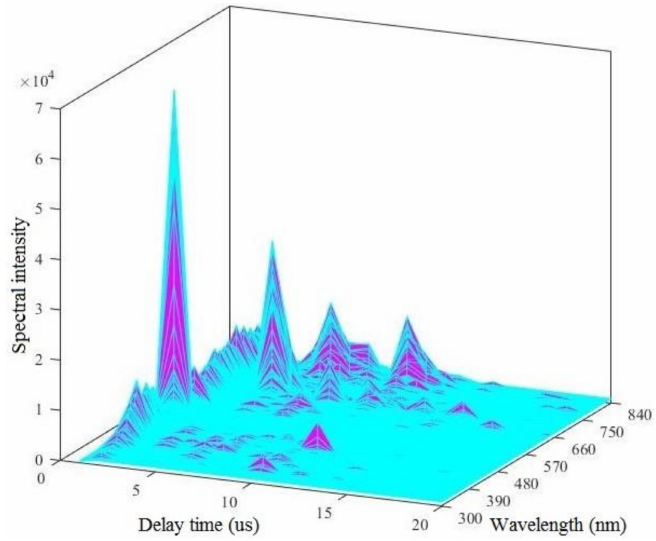
Figure 3. Three-dimensional LIBS